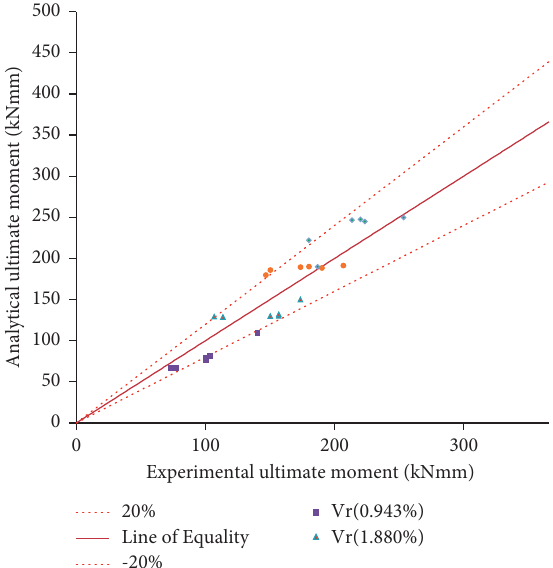
Figure 12: Correlation between analytical moment and experimental moment for ferrocement